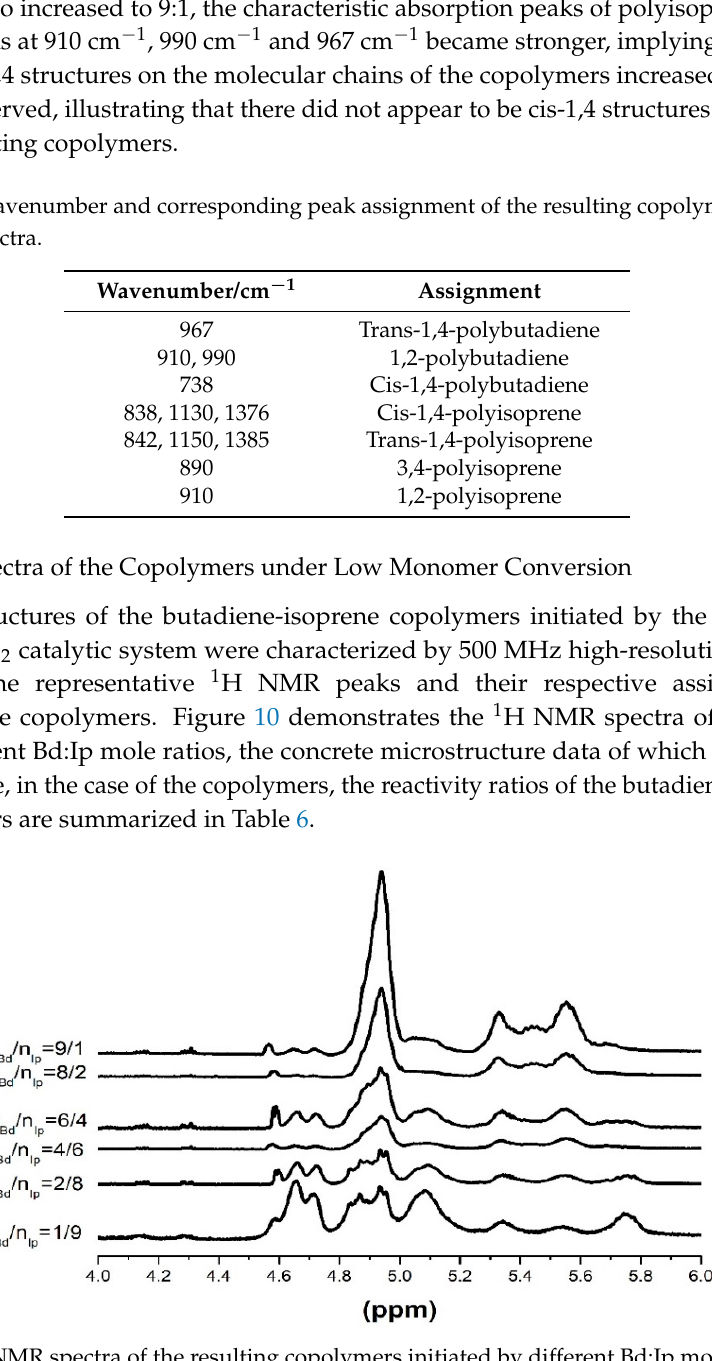
Figure 10. 1 H NMR spectra of the resulting copolymers initiated by different Bd:Ip mole ratios from 9:1 to 1:9. Polymerization conditions: [M] = 0.18 g · mL − 1 , TNPP:Mo = 6, Al:Mo = 5, T = 60 ◦ C, Mo:[M] = 8 × 10 − 4 , t = 7 h. Table 4. Representative peaks and corresponding peak assignment of the butadiene-isoprene copolymer.